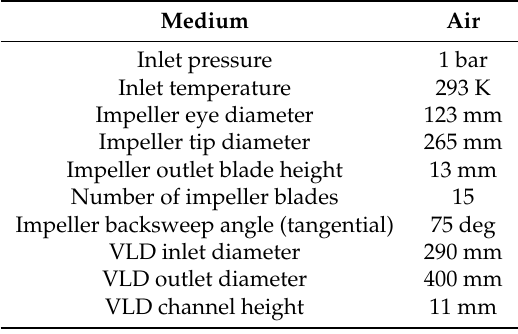
Figure 1. Layout functional scheme of the experimental rig. Table 1. Operational and geometric parameters of the tested stage.